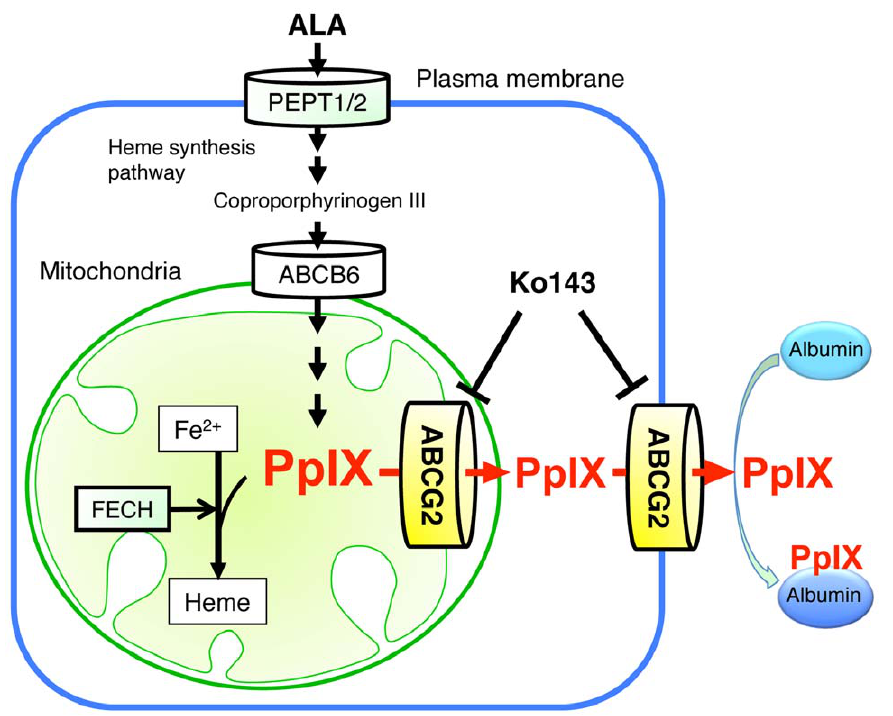
Figure 12. Involvement of mitochondrial ABCG2 in the regulatory mechanism of ALA-mediated PpIX accumulation in malignant cells. PEPT1/2, oligopeptide transporters; ABCB6, ABC transporter B6.